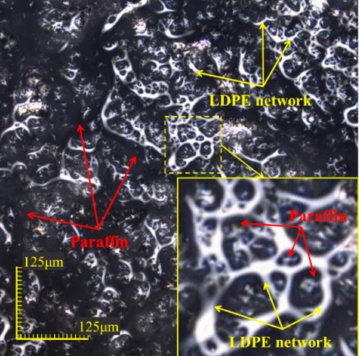
Figure 5. LSCM image of SSPCM network